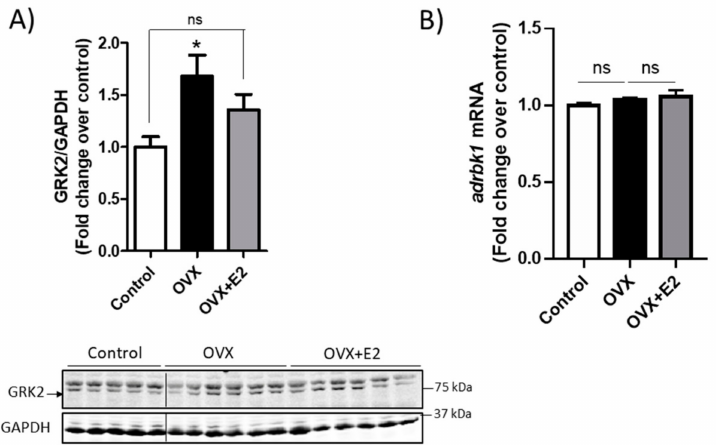
Figure 3. Cardiac GRK2 protein levels are modulated by sexual hormones in rats. Cardiac lysates from female ovariectomized (OVX) animals and OVX rats, supplemented with 17 β -estradiol (OVX + E2), were subjected to WB with antibodies against GRK2 and GAPDH, n = 5–6 ( A ) or to mRNA extraction and qPCR to assess adrbk1 levels (normalized to rpl32 and 18 s ) n = 5–10 ( B ). Representative immunoblots and densitometric analysis are shown, results are represented as means ± SEM, statistical analyses were performed using one-way ANOVA followed by Bonfer- roni’s post-hoc test ( A , B ) * p <